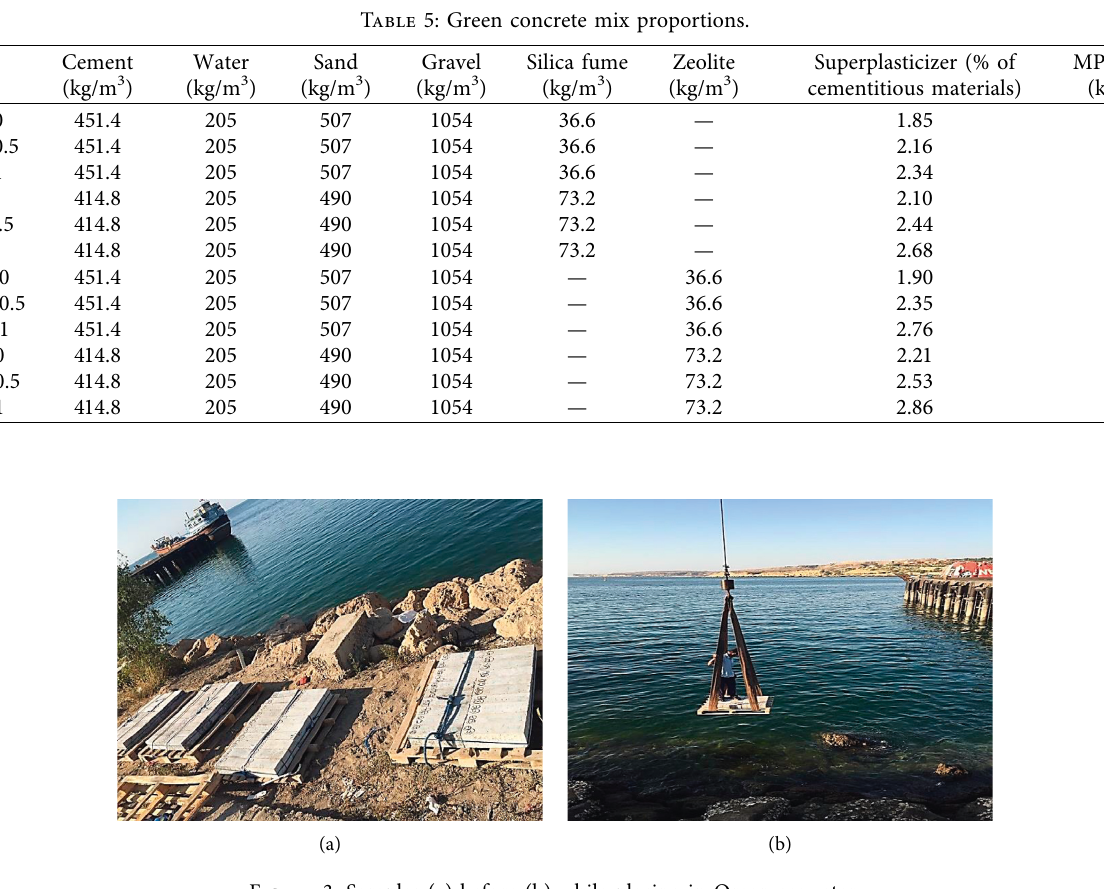
Figure 3: Samples (a) before (b) while placing in Oman